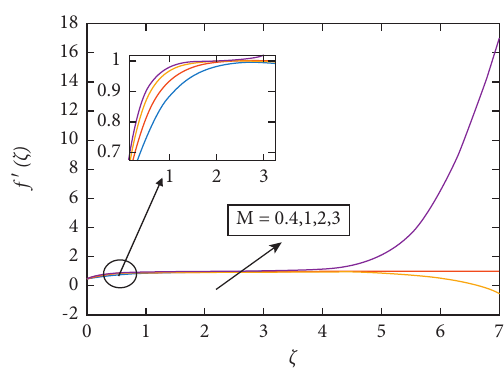
Figure 7: φ variation on φ ( ζ ) . 2